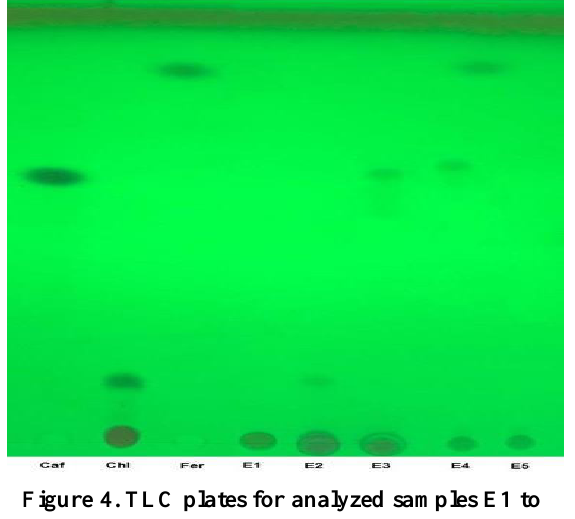
Figure 4. TLC plates for analyzed samples E1 to E5 developed in the Chloroform:acetone:formic acid (75:16.5:8.5) at 254nm. (Fer=ferulic acid, EA=ethyl acetate fraction.